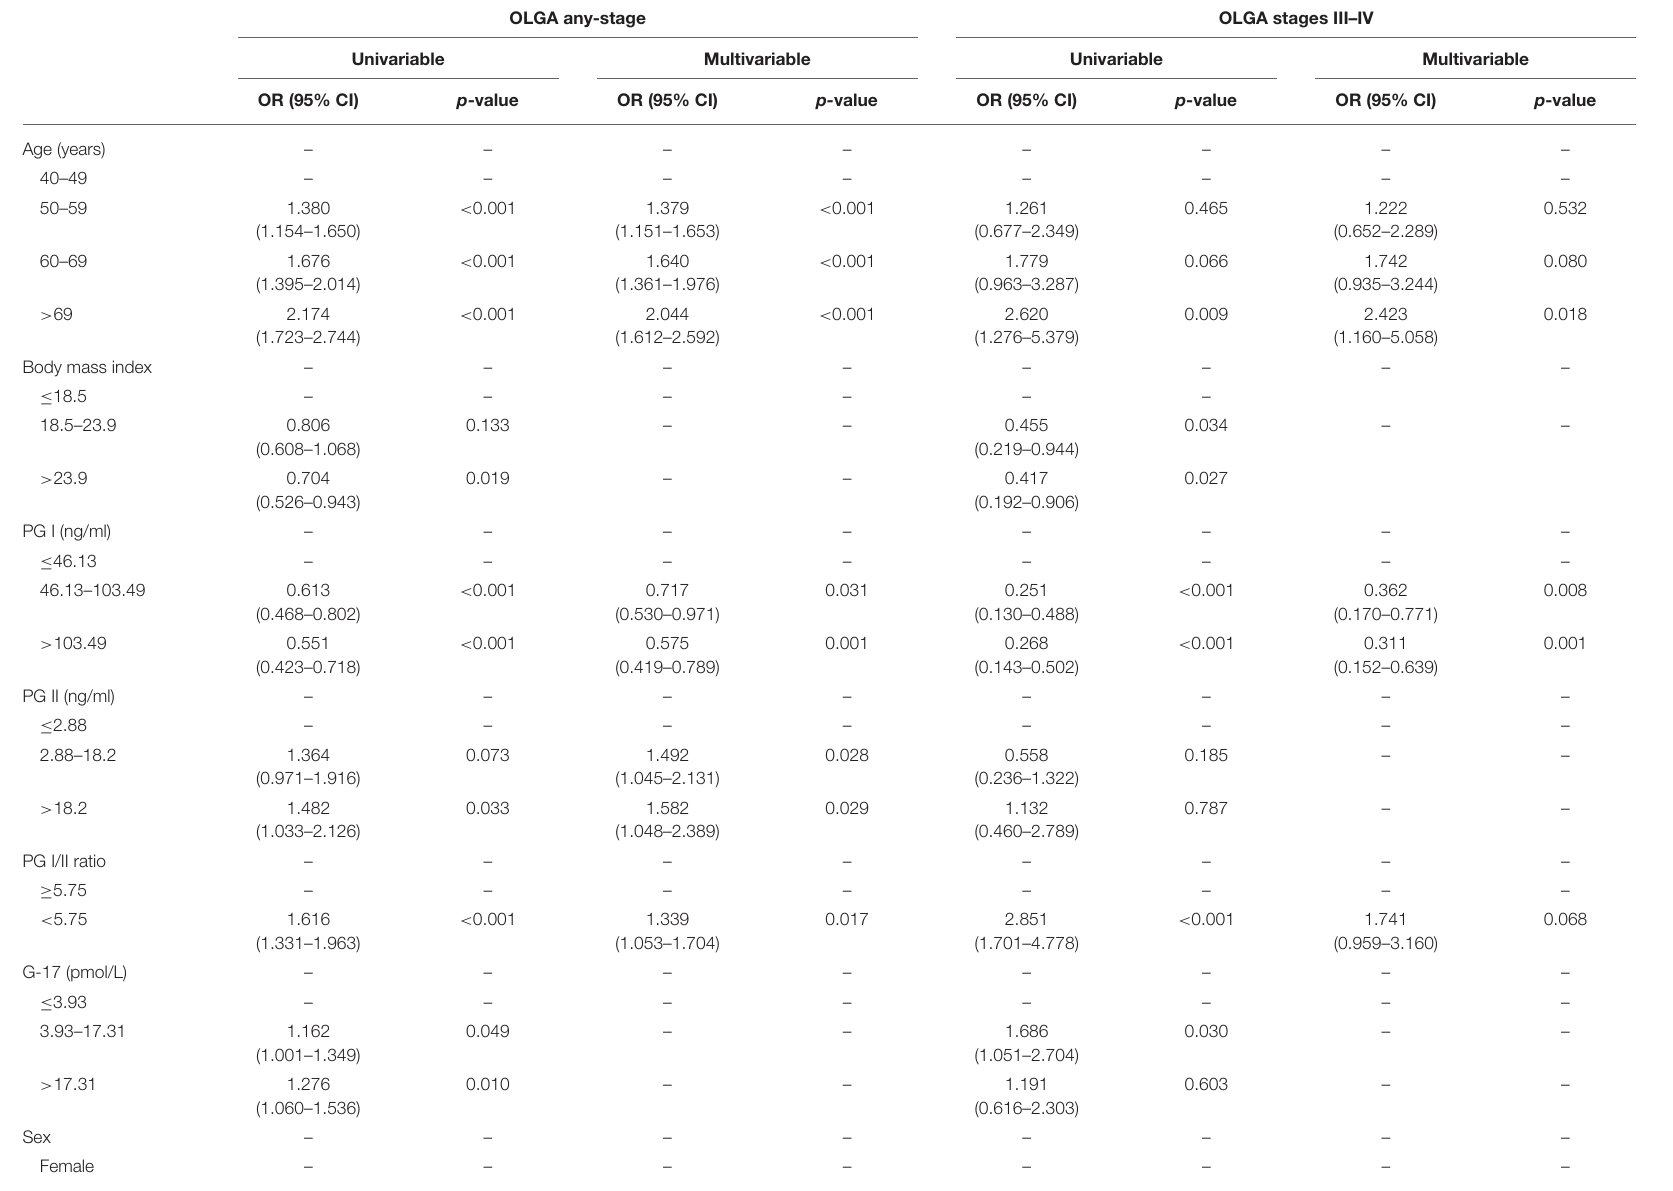
TABLE 3 | Logistic regression model showing the association of variables with OLGA any-stage and OLGA stages